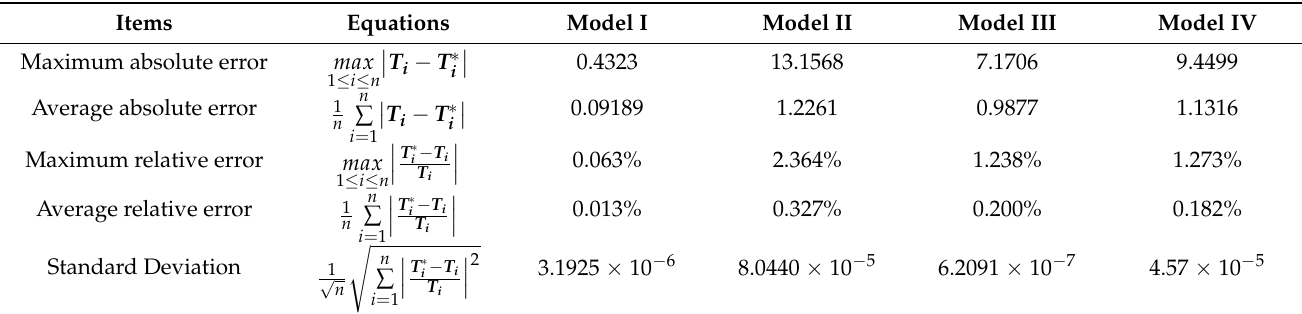
Table 3. Comparison of the errors in four models.